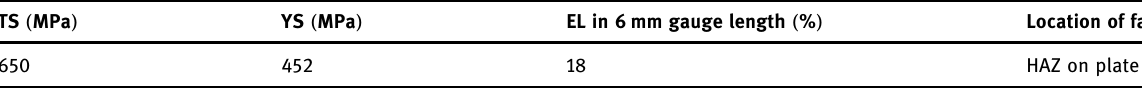
Table 4: Tensile properties of dissimilar rod - to - plate joint